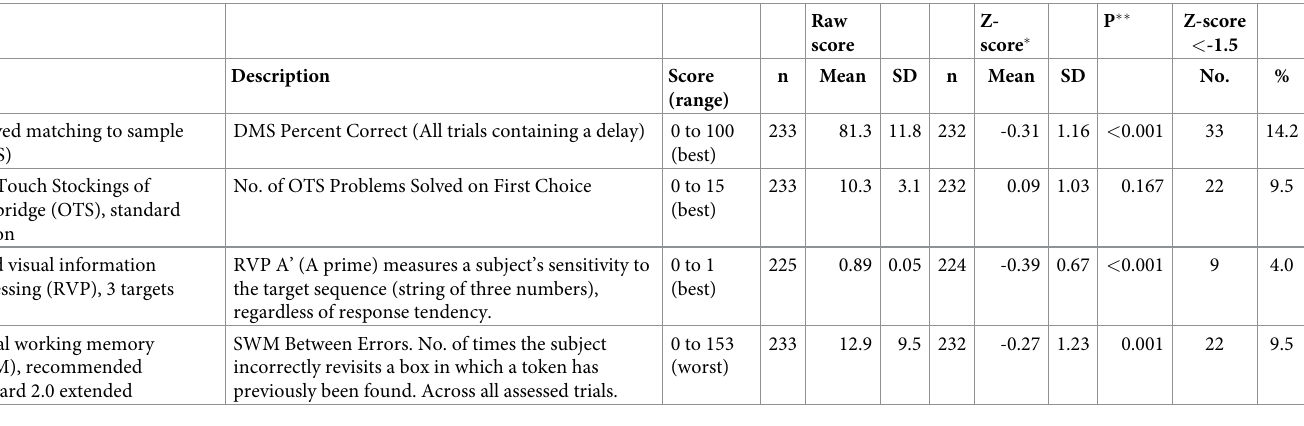
Table 3. Cognitive test scores and comparison with norm